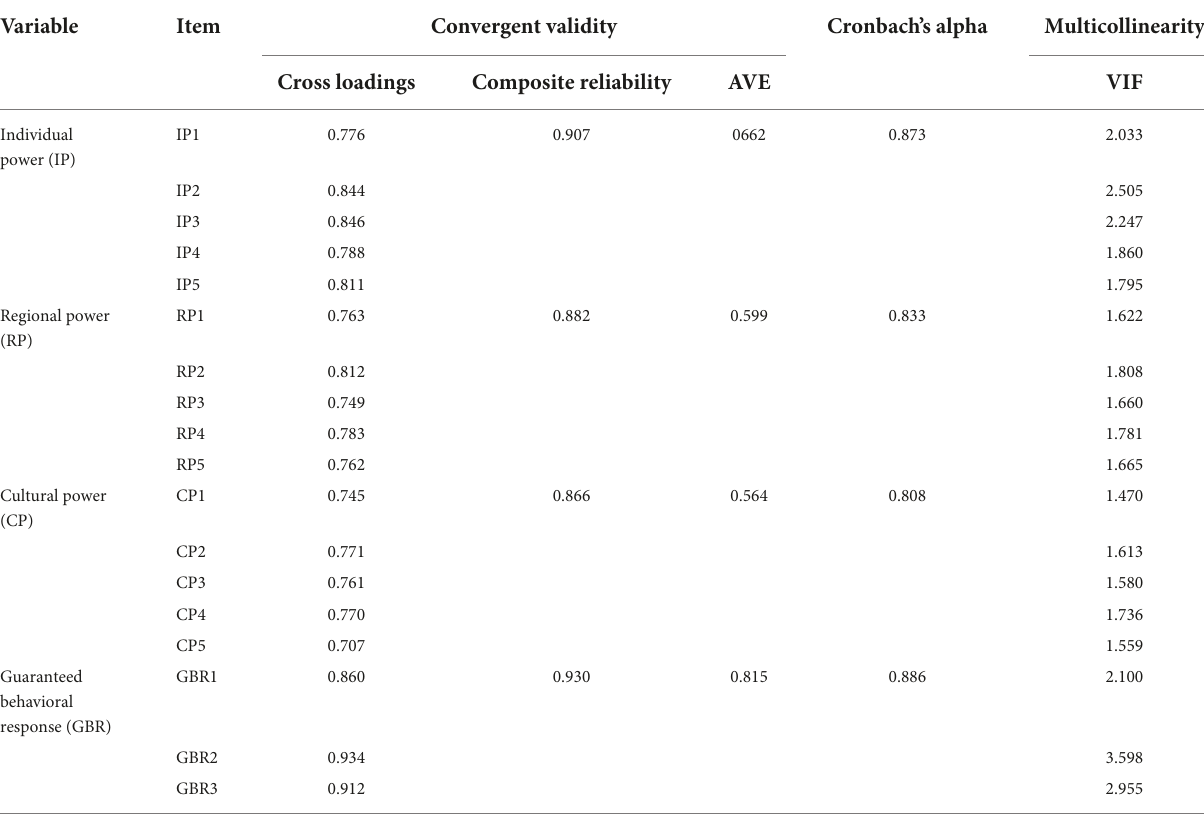
TABLE 3 Reliability and validity.